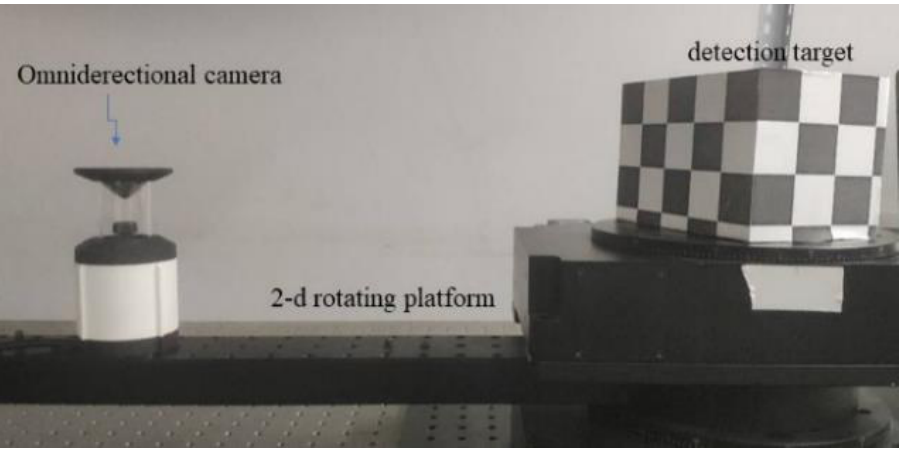
Figure 5. Experimental layout.